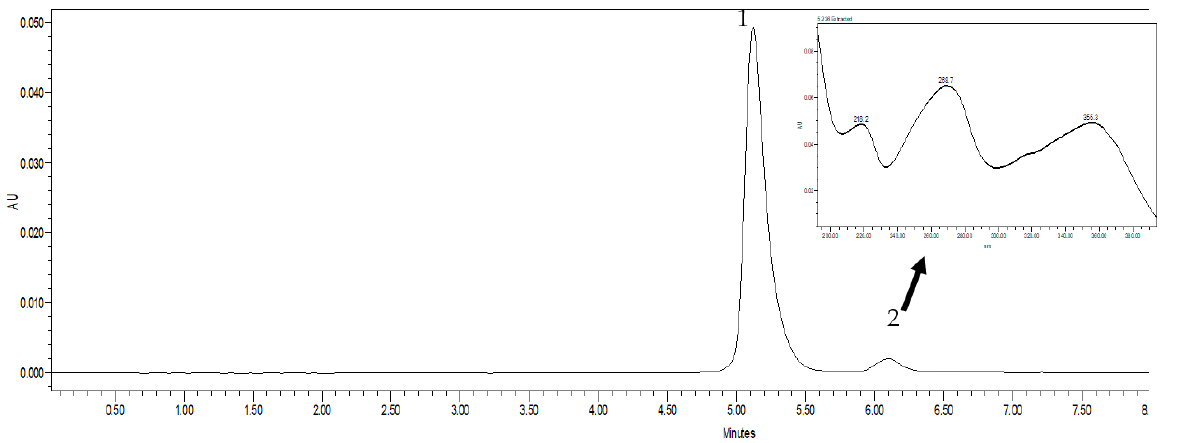
Figure 5. Chromatogram of oxytetracycline in the polyphosphate ester-type P4 transporter.